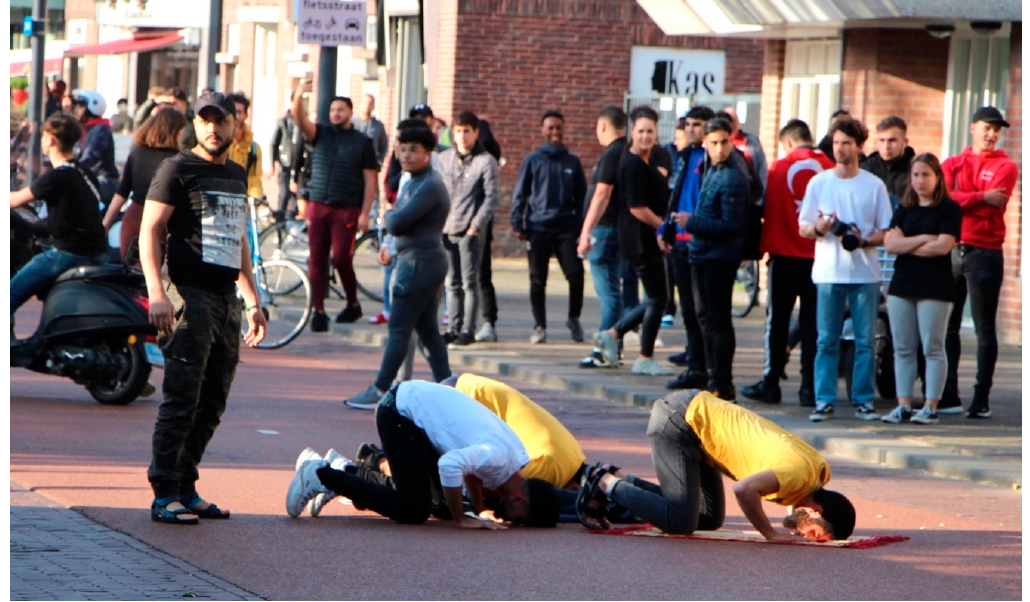
Figure 2. Counter-protesters performing a congregational prayer in the middle of the street. Photo taken by the author.